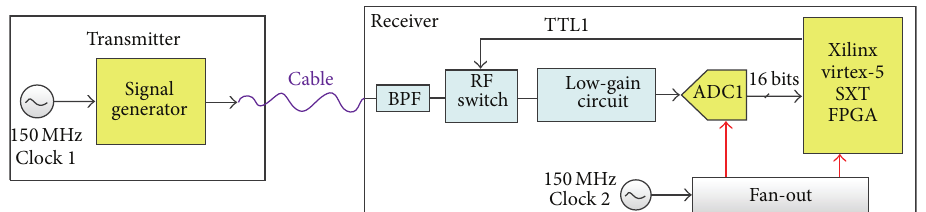
Figure 3: Obtain the reference signal of the 𝑚 -sequence in close-loop situation.